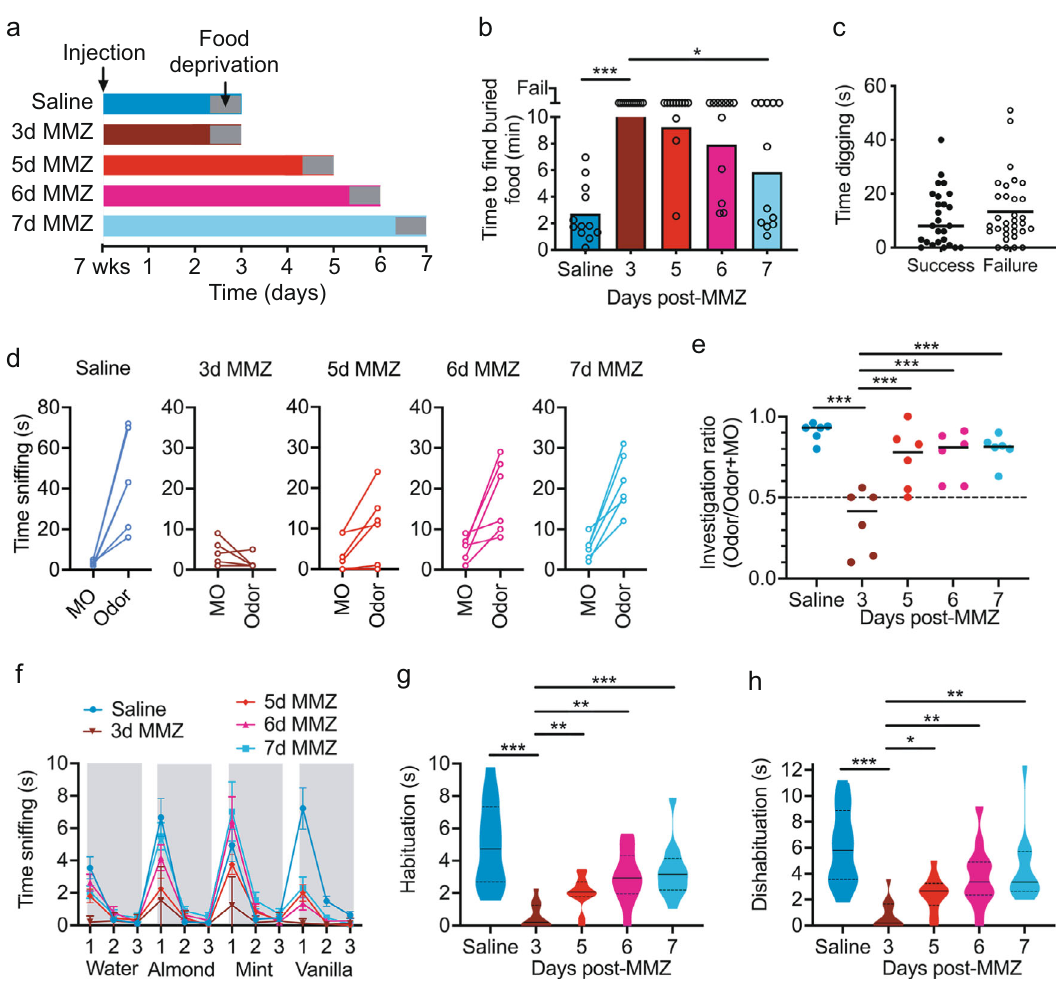
Fig. 10 | Mice can detect and discriminate odors using only immature OSNs. a Experimental design. b Buried food assay performance improved from 5d-MMZ to 7d-MMZ (One-way ANOVA on Ranks. P <0.001, Kruskal – Wallis statistic=31.6. Dunn ’ s multiple comparisons. Saline, P <0.001, Z =5.10; 5d-MMZ, P >0.99, Z =0.86; 6d-MMZ, P =0.47, Z =1.56; 7d-MMZ, P =0.017, Z =2.86; all vs. 3d-MMZ, n =12 mice per group). Bars: mean, symbols: individual mice. c Similar acclimation period digging time for buried food assay success vs. failure (Mann – Whitney test. P =0.44, U =367, n =58 mice). Lines: median, symbols: individual mice. d Time snif fi ng mineral oil (MO) vs. Nutter Butter (Odor). Symbols: individual mice. e Greater investigation ratio in other groups vs. 3d-MMZ (One-way ANOVA. ’ smultiplecomparisons.Vs.saline:3d-MMZ, P <0.001, P <0.001, F 4,26 =11.96.Sidak t =6.43; 5d-MMZ, P =0.20, t =1.88; 6d-MMZ, P =0.20, t =1.73; 7d-MMZ, P =0.23,